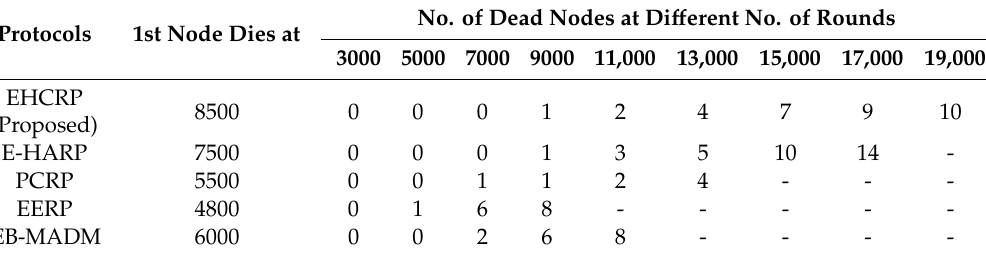
Table 4. Lifeless Nodes vs.